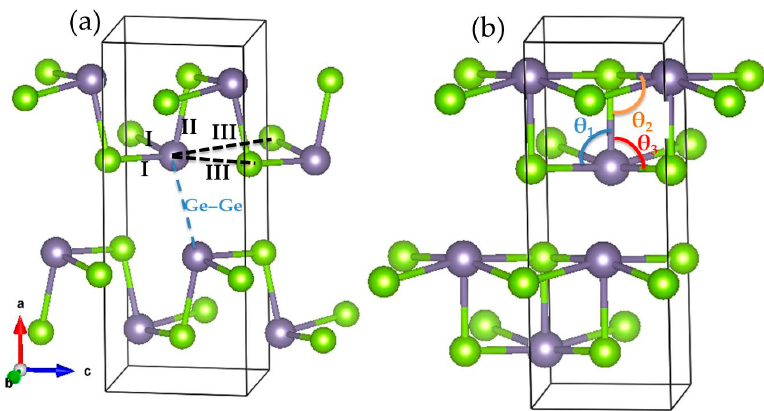
Figure 1. Crystal structure of GeSe with the ( a ) Pnma and ( b ) Bbmm of GeSe. The nearest Ge–Se bonds are shown with double color lines.